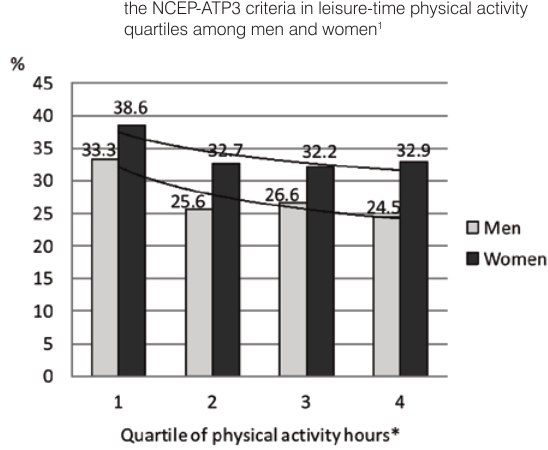
Figure 1. Prevalence of the metabolic syndrome according to the NCEP-ATP3 criteria in leisure-time physical activity quartiles among men and women